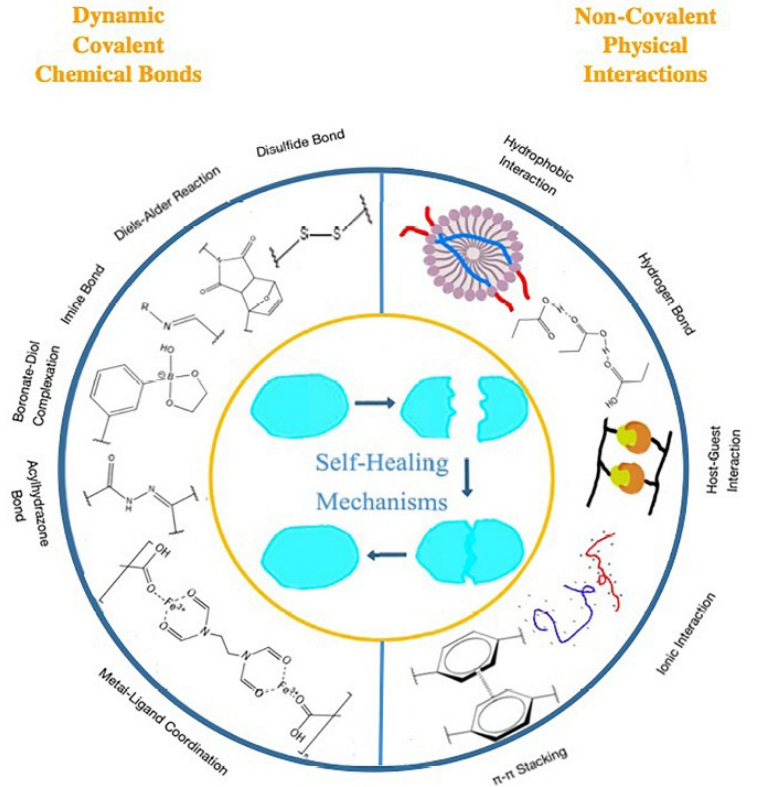
Figure 5. Self-healing mechanisms: Chemical covalent bonds and physical non-covalent interac-